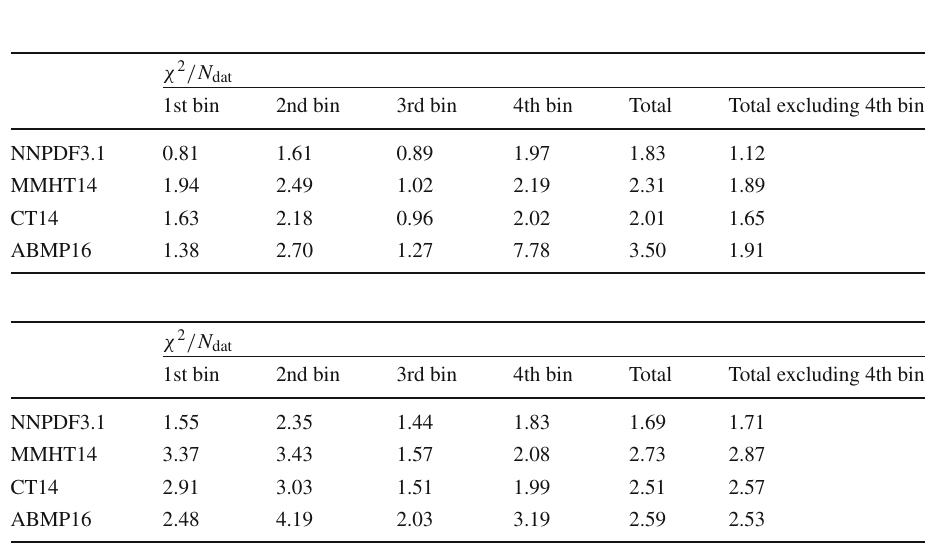
tal statistical and systematic uncertainties have been added in quadra- ture. The error bands for the theory predictions include only the PDF uncertainties